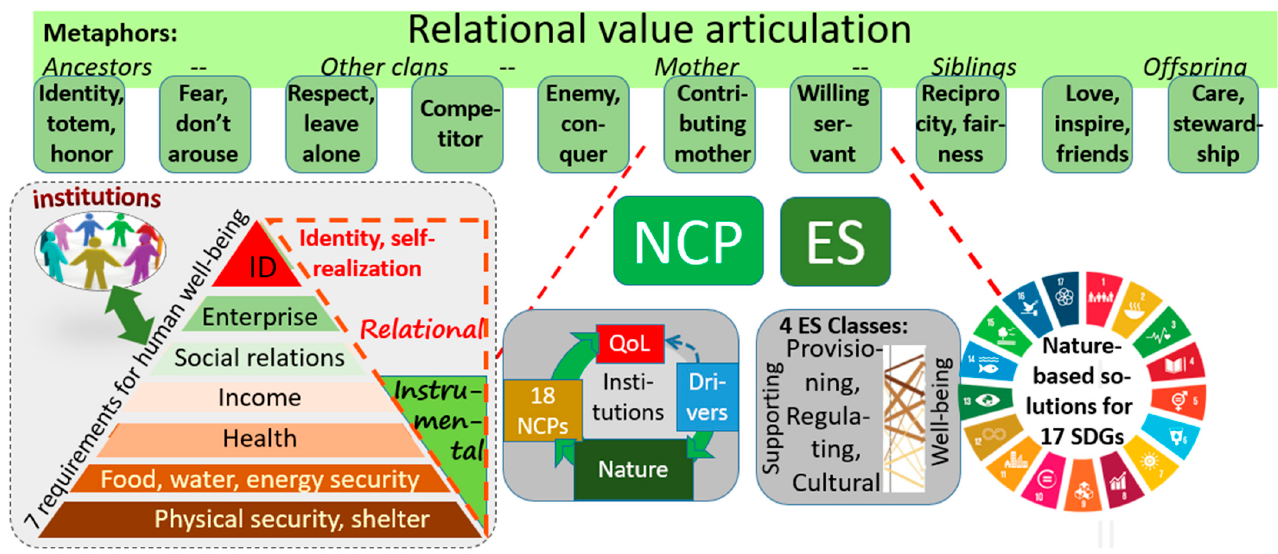
Figure 7. Portrayal of instrumental as a specific subset of relational values [7], including the material values involved in a modified Maslow pyramid of human wellbeing [59] and nature-based solutions [60] to the various SDGs.